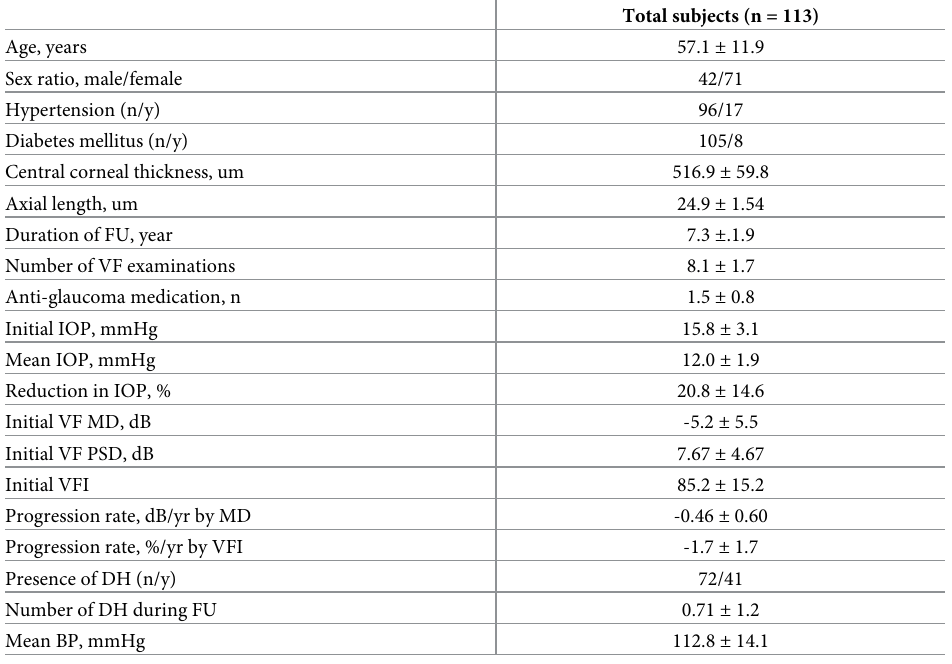
Table 1. Clinical characteristics of the NTG